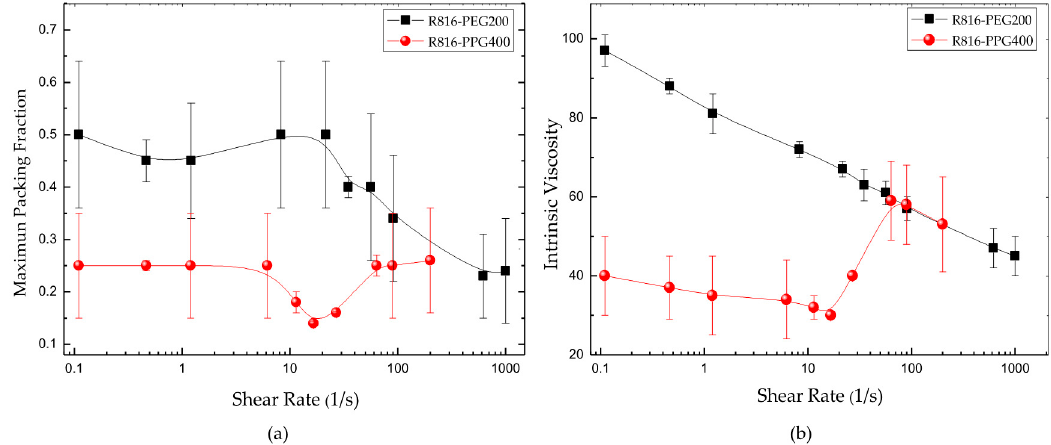
Figure 7. ( a ) Maximum packing fraction of R816 in PEG200 and PPG400 vs. shear rate. ( b ) Intrinsic viscosity of R816 in PEG200 and PPG400 vs. shear rate.